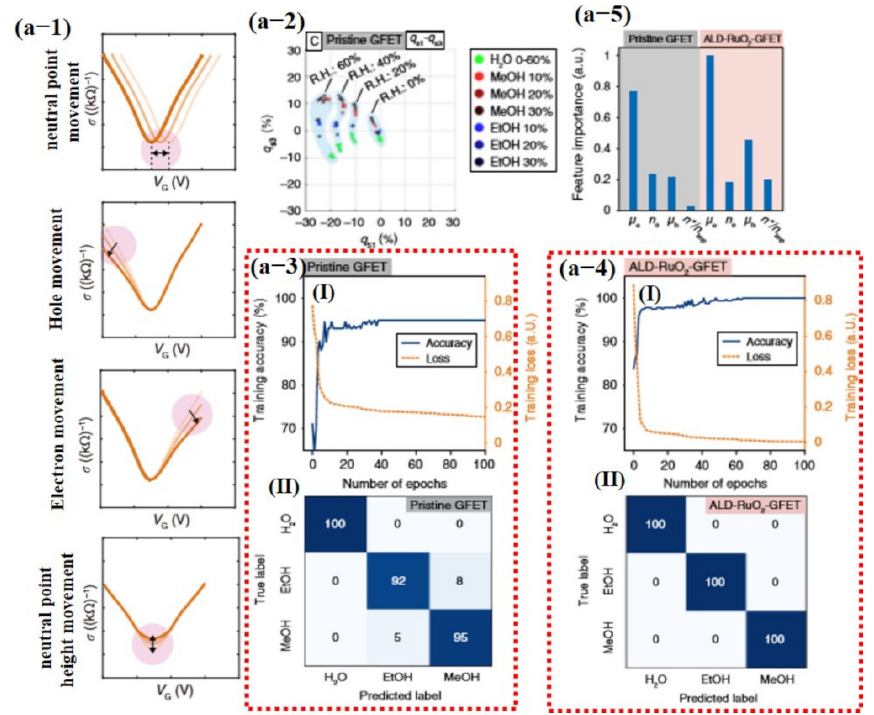
Figure 18. Pristine graphene and AL-RUO 2 -based GFET devices for detection of different compounds under dry and humid environments. (a-1) Schematic illustration of extracted features for data processing, movement of the charge-neutral point (Np), variation in hole branch, variation in electron branch, and variation in height of the charge Np. (a-2) 3D gas-sensing patterns of the binary gas mixtures projected onto a representative 2D plot. The gas-sensing patterns are grouped by light blue colored regions, and the corresponding background relative humidity (R.H) levels are labeled. (a-3 ( I )) Training accuracy and the training loss history from results using the pristine graphene; ( II ) confusion matrix of the pristine GFET. (a-4 ( I )) Training accuracy and the training loss from results using the ALD-RuO 2 GFET; ( II ) confusion matrix of the ALD-RuO 2 GFET with 100% true values. (a-5) Normalized feature importance for the eight tested features. Reproduced with permission from [140], copyright 2020 Springer